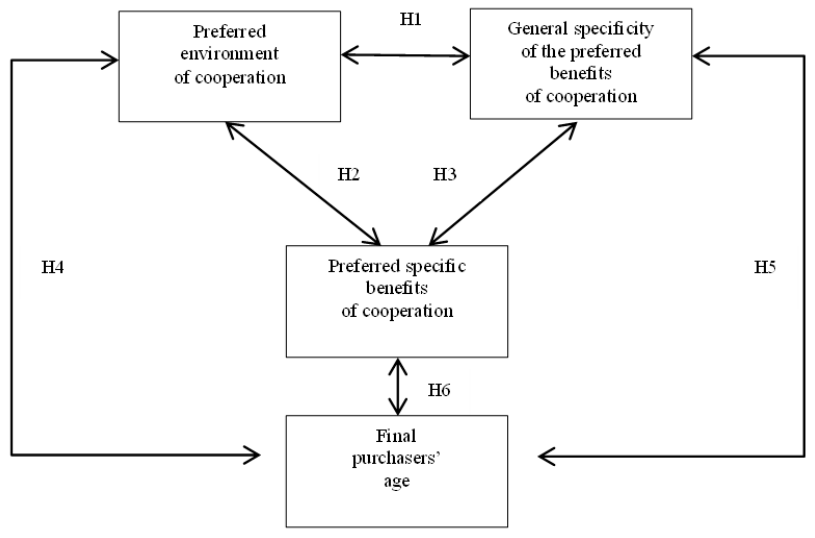
Figure 1. Conceptual